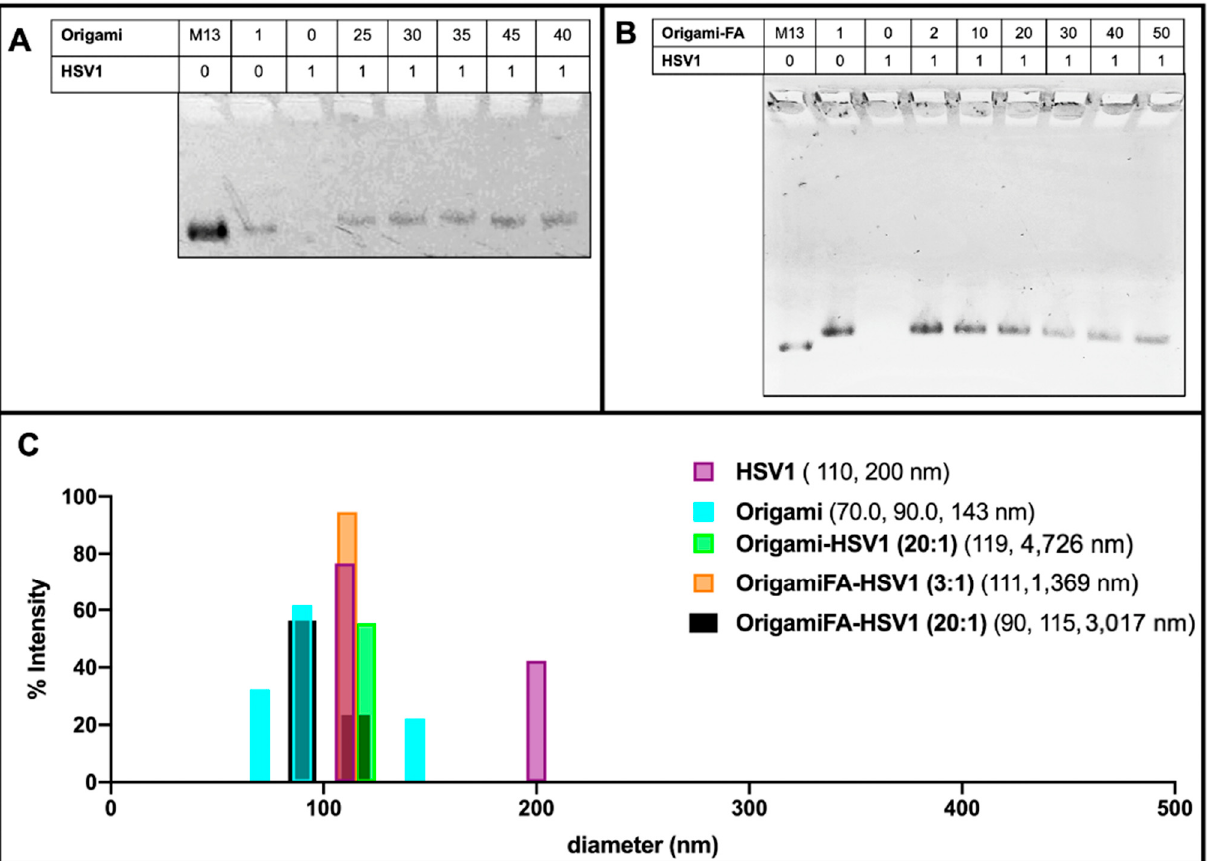
Figure 3. Electrostatically HSV1 particle-loaded DNA Origami. ( A ) 1% Agarose Mobility Shift Assay (AMSA) analysis of HSV1-loaded origami shows a sudden change in mobility between 35:1 and 40:1 origami:HSV1 ratios from otherwise decreased mobility, suggesting the critical packing ratio and ( B ) Folic-Acid adorned origami similarly loaded with HSV1 particles, where 20:1 is the demonstrated critical packing ratio. Both ( A , B ) also show a decreased mobility from the free M13mp18 scaffold strand to the fully annealed DNA Origami in the first two left lanes of both gels. ( C ) Dynamic Light Scattering validation of HSV1 particle and DNA Origami size dimensions where occasional dimerized configurations were observed. Data also confirms the complex package sizes at a 2:1 ratio origami-HSV1 and 3:1 ratio of origami Folic Acid to HSV1 complexes. No leftover origamis are observed, but agglomeration is noted.